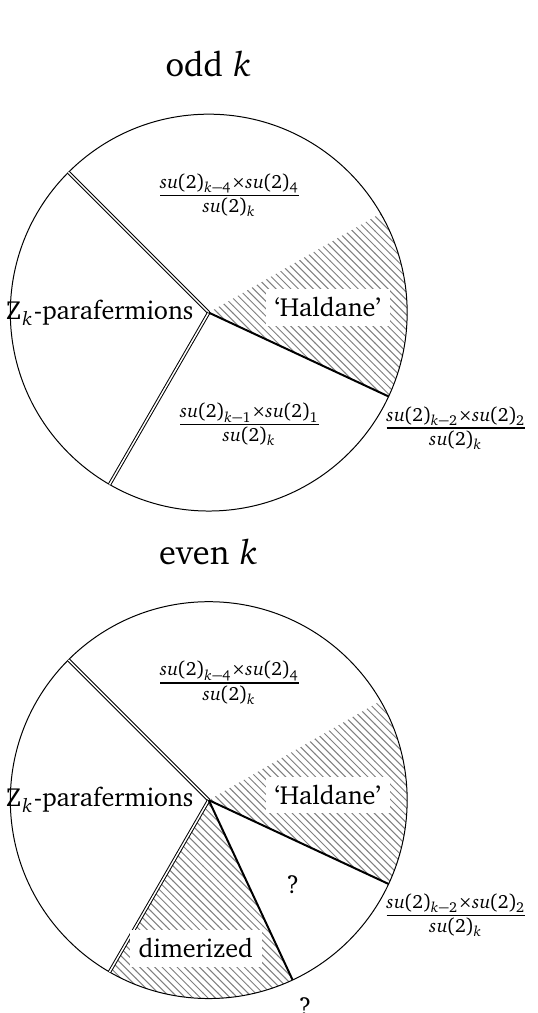
Figure 1: Phase diagram of anyonic spin chains proposed in [ 9 ] for k > 4 odd (left) and even (right). The nature of the different phases is explained in detail in that reference. We have denoted by doubled lines first order phase transitions. The ‘Haldane’ and dimerized phases, hashed on the figure, are massive. In the case of k even, the extended region denoted by a question mark is referred to in [ 9 ] as an ‘extended critical phase’, whose precise nature was left unelucidated. The nature of the transition between this phase and the dimerized phase was also not elucidated in [ 9 ] , and we denote this in the figure by another question mark. All the other regions are supposed to be gapless, and described at low energy by the CFTs indicated on the